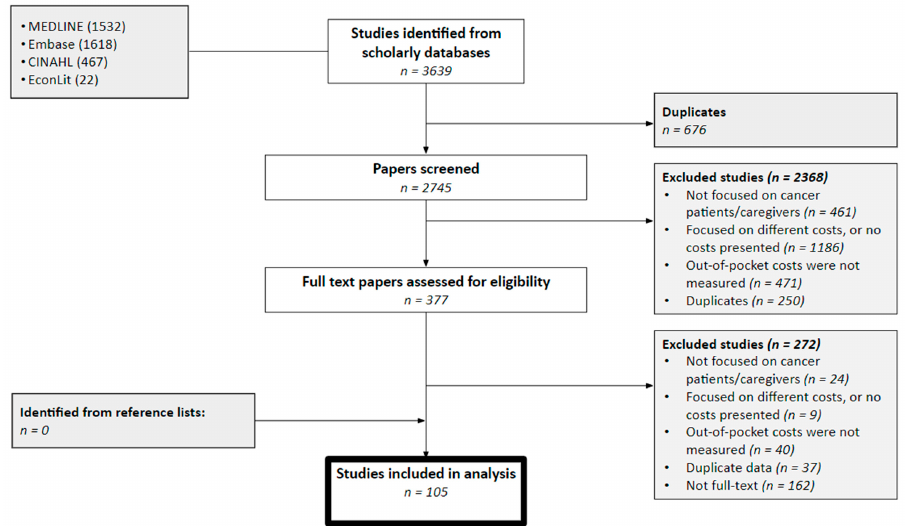
Figure 1. Preferred Reported Items for Systematic Reviews and Meta-Analyses (PRISMA) diagram. Note: This diagram shows the flow of information through the different sections of the systematic review, including the identified, excluded and included studies after the title/abstract and full-text reviews.